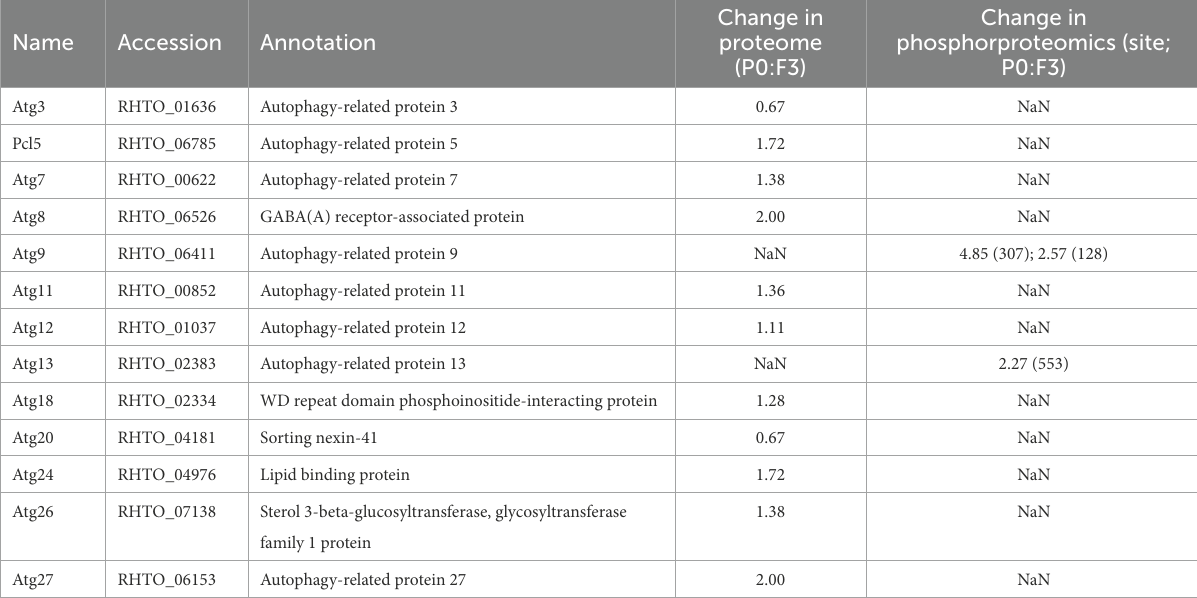
TABLE 2 List of the regulation of autophagy-related proteins in proteome and phosphoproteomics.